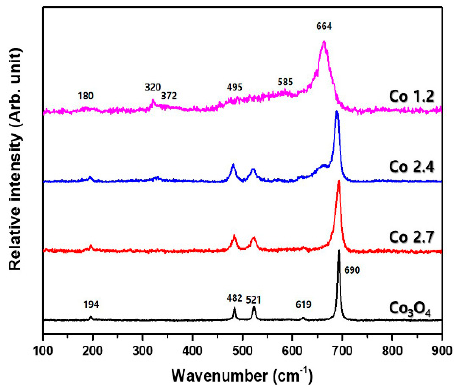
Figure 4. Raman spectra of Co- and Mn-based the mixed phase materials with different Co contents (Co = 1.2, 2.4, 2.7, and 3).